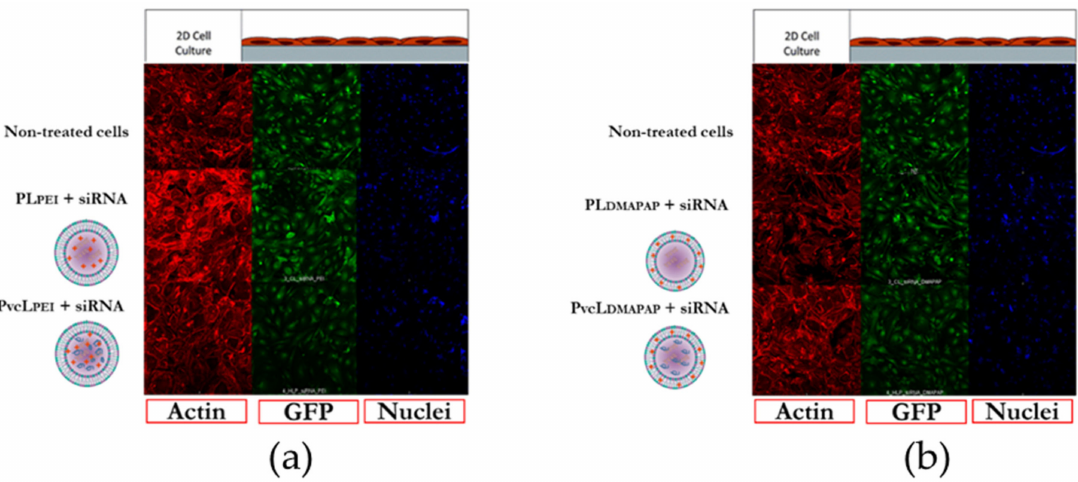
Figure 5. Confocal imaging of endothelial cells treated with various formulations in vitro. ( a ) Non-treated PL PEI and PvcL PEI ; ( b ) non-treated PL DMAPAP and PvcL DMAPAP treated